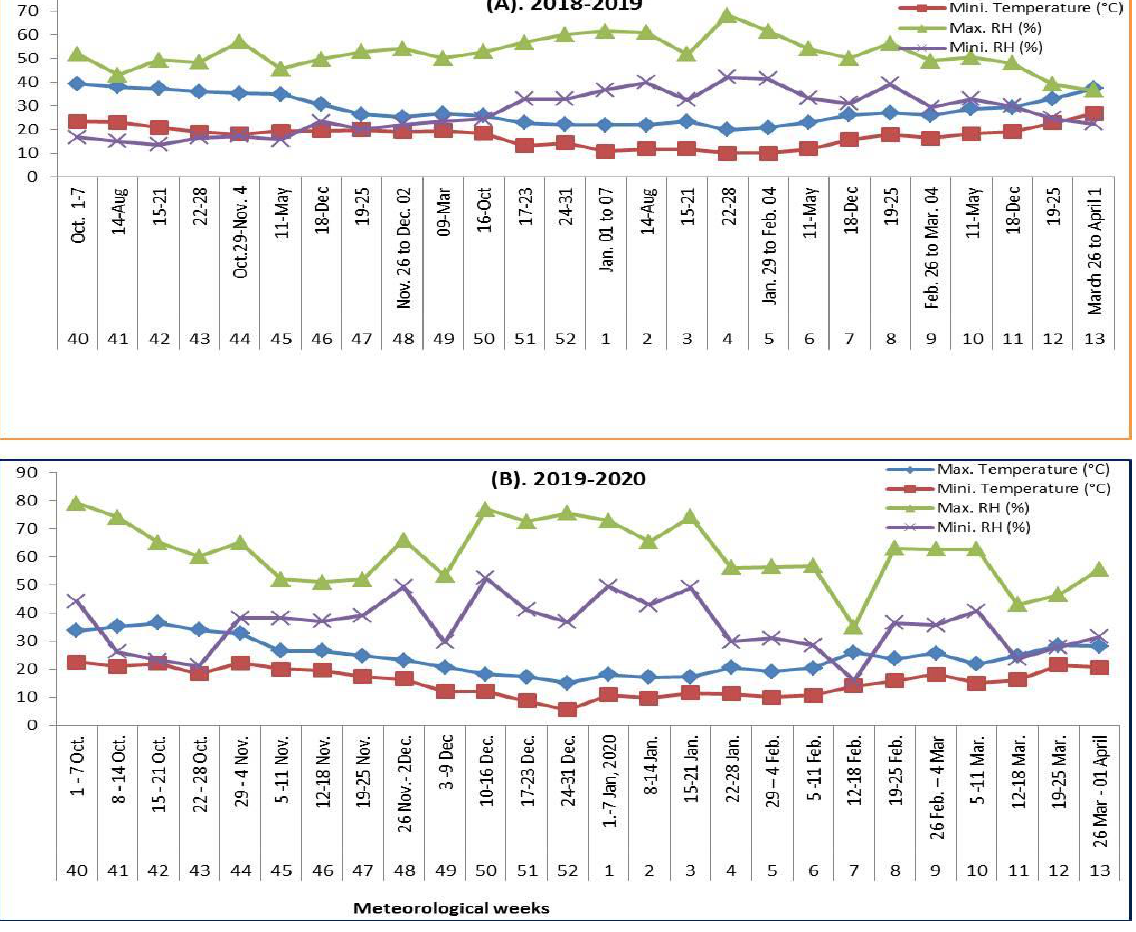
Figure 1. Weekly meteorological parameters during rabi season of the year 2018–2019 ( A ) and 2019–2020 ( B ).